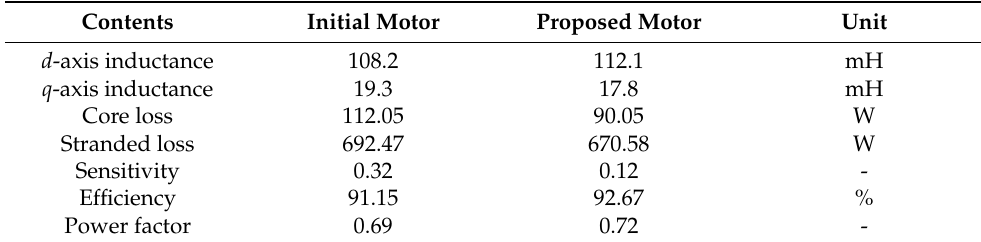
Table 2. Output characteristics of initial motor and proposed